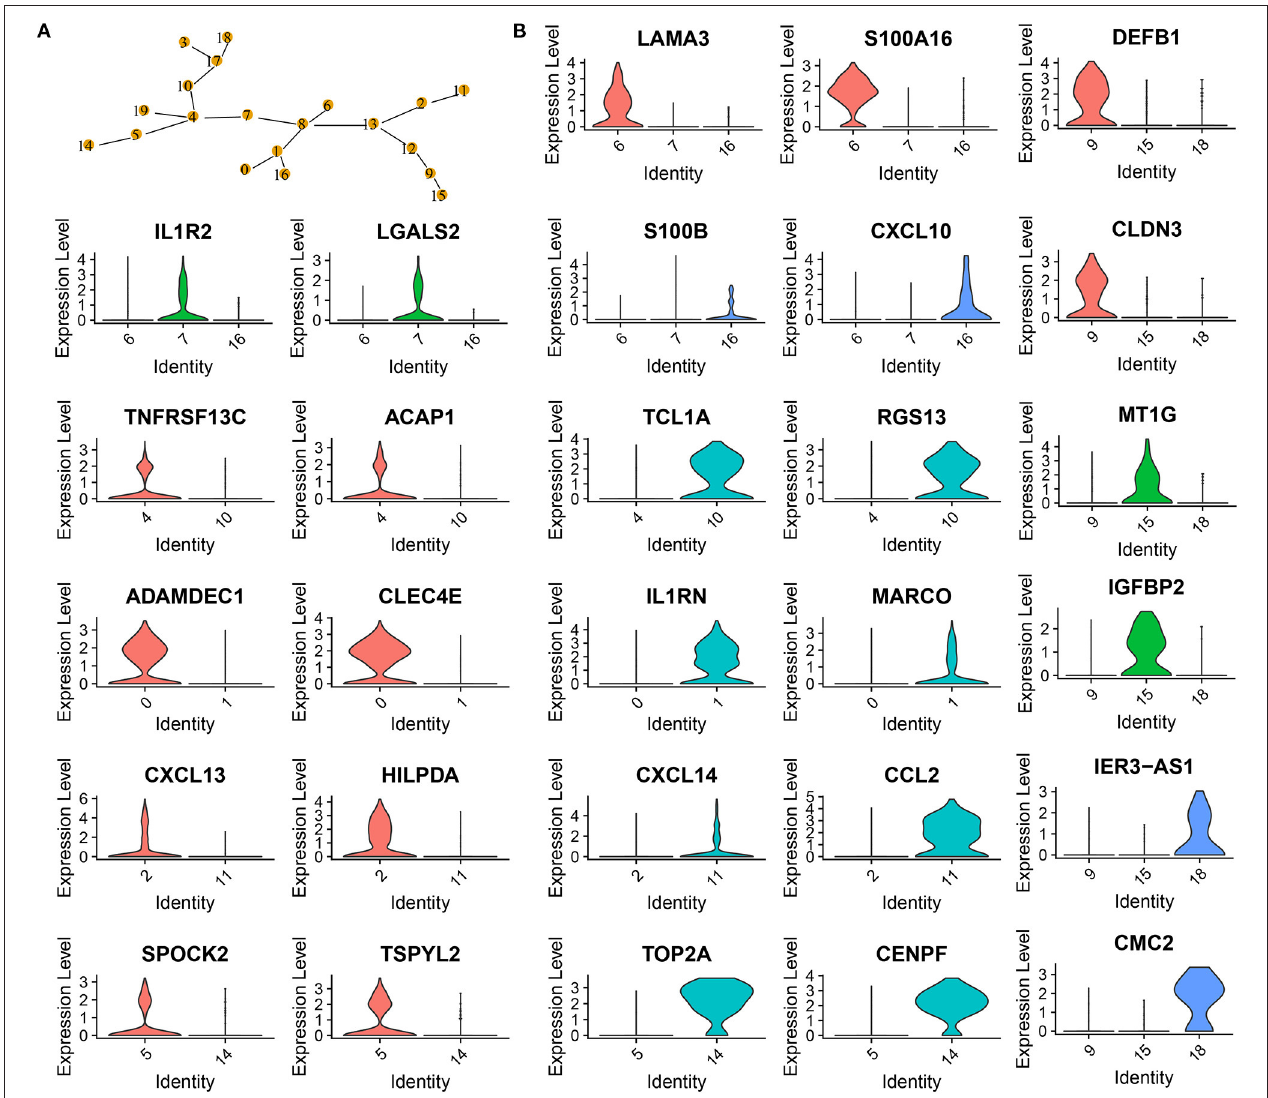
FIGURE 3 | Confirmation of 20 subgroups. (A) MST of 20 subgroups. Yellow points labeled with different numbers represents different subgroups. (B) Violin plots showing marker genes expressed in different